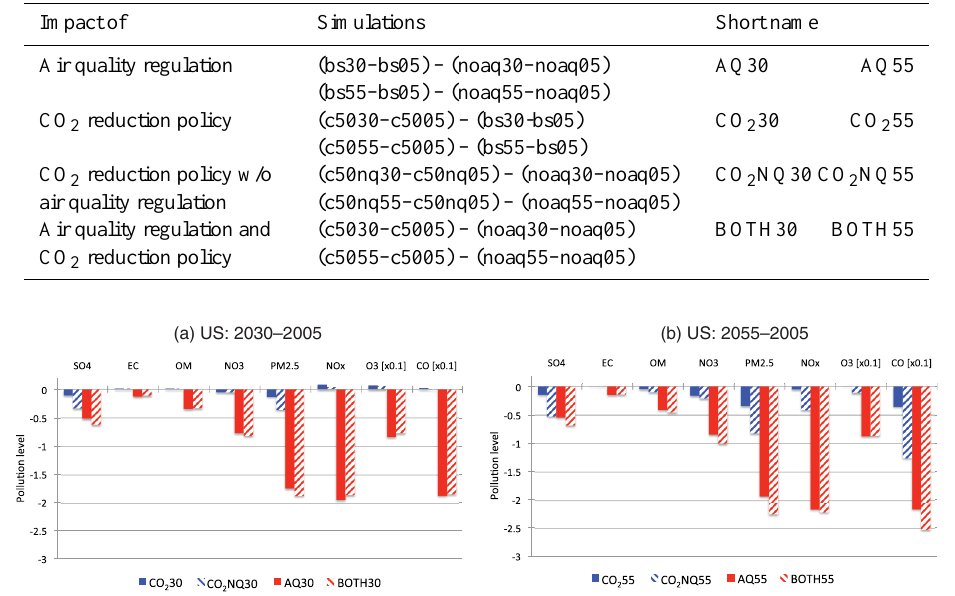
Figure 2. Changes in the US mean air pollution in 2030 and 2055 with respect to 2005 due to the air quality regulations and CO 2 reduction policy (averaged over the 50 US states). All PM has a unit of µgm − 3 , and gases have a unit of ppb. O 3 and CO are multiplied by 0.1 to plot in the same y axis scale as others. See Table S2 in the Supplement for the exact